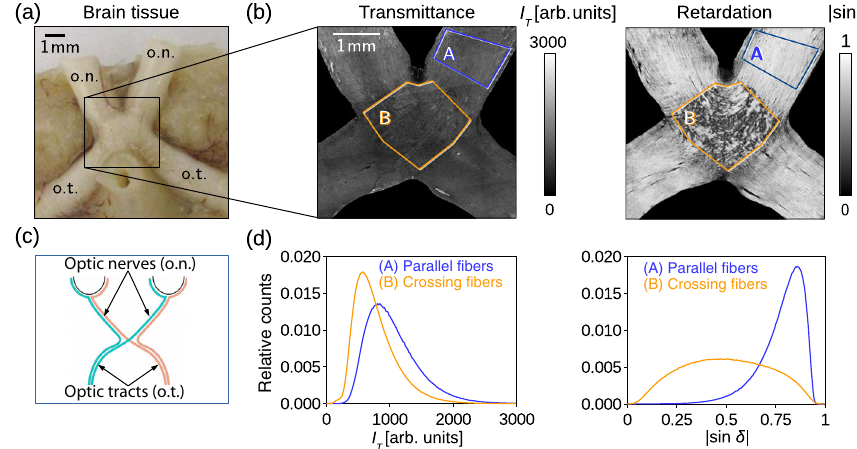
FIG. 4. Crossing nerve fibers in the optic chiasm of a hooded seal: (a) brain tissue before sectioning, (b) unnormalized transmittance and retardation images of the middle brain section obtained from 3D-PLI measurements with 1 . 33 μ m pixel size, (c) schematic drawing of the optic chiasm consisting of optic tracts (o.t.) and optic nerves (o.n.), (d) normalized histograms of the transmittance image ( I retardation image ( j sin δ j ) for a region with mostly parallel fibers (blue) and a region with nearly 90°-crossing fibers (orange). Unlike the retardation, the transmittance does not depend on the crossing angles of the nerve fibers, only on the tissue density. More information about the sample can be found in Dohmen et al. [56] [(a) and (c) are adapted from Figs. 1 and 5B0 in [56] copyright 2015, with permission from